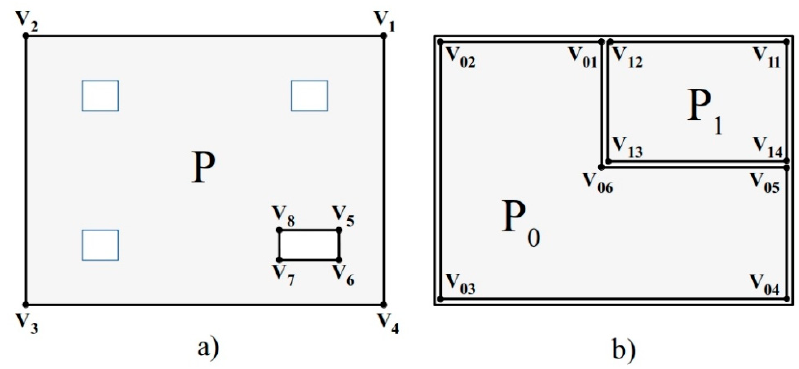
Figure 3. Geometric representation of navigable space ( a ) in case of the existence of holes and columns (blue lines), ( b ) in case of the existence of rooms.